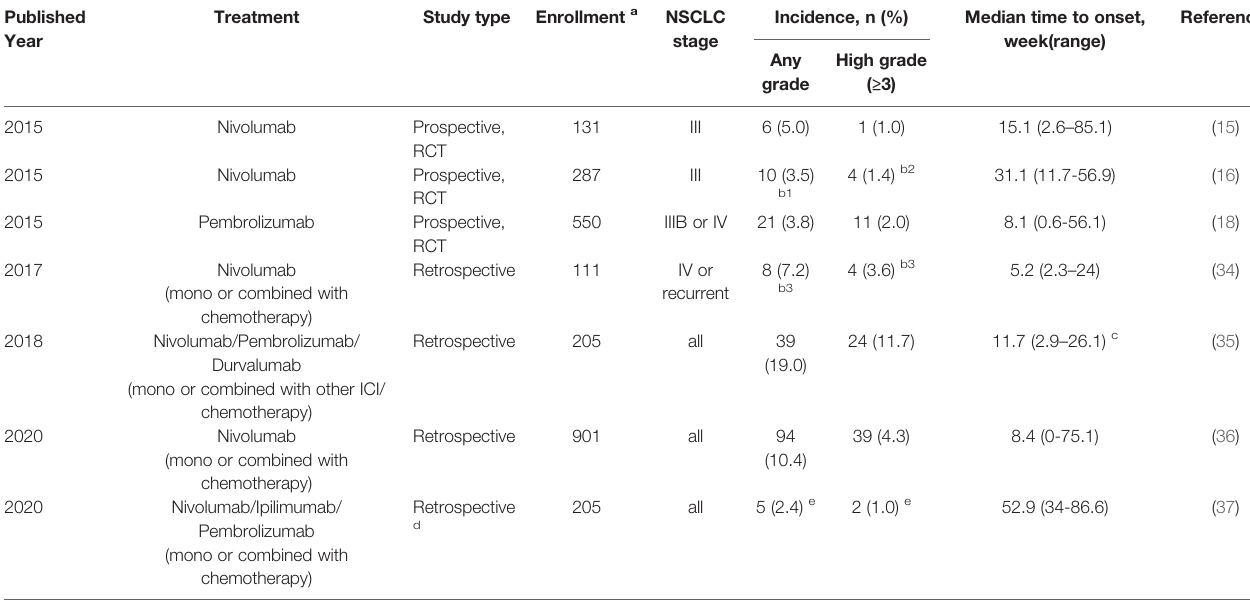
TABLE 2 | Study that reported the onset time of checkpoint inhibitor pneumonitis (CIP) in NSCLC patients with PD-1/PD-L1